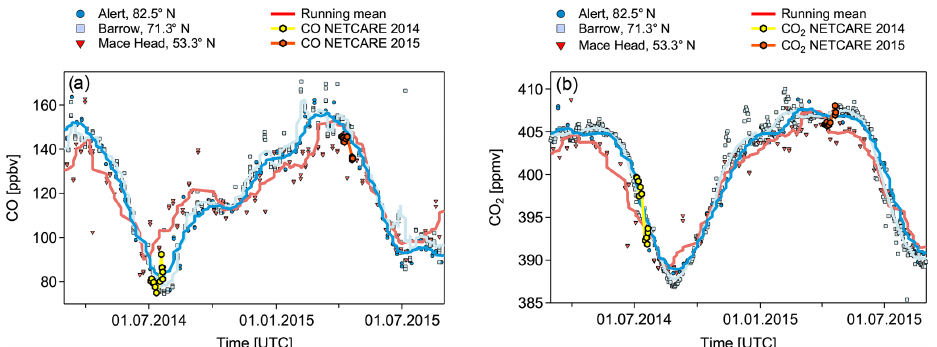
Figure 4. CO (Dlugokencky et al., 2018) (a) and CO 2 (Petron et al., 2018) (b) seasonal cycle based on NOAA ground-based measurements in Alert (Canada), Barrow (Alaska), and Mace Head (Ireland) for the years 2014 and 2015. Running means (10 points) are shown for the respective station data (symbols). Mean aircraft data for altitudes lower than 200m for individual flights are overlaid. Error bars (yellow and orange shading) for the aircraft data are too small to be visible. NETCARE 2014 data are in yellow and NETCARE 2015 data are in orange.